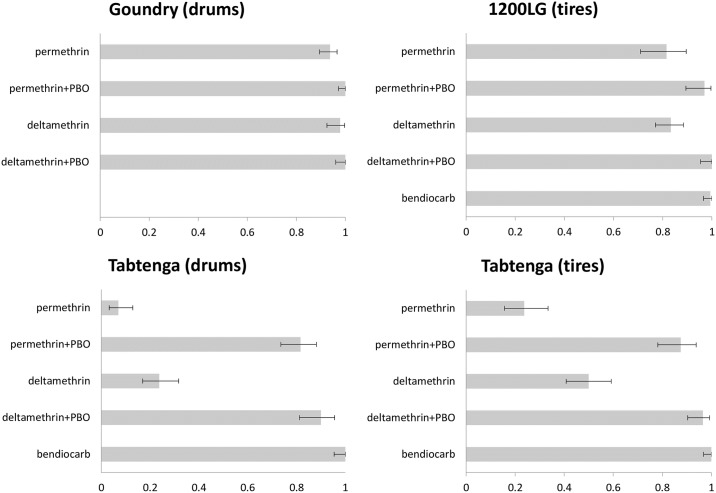
CDC 2h bottle bioassay mortality (x-axis) from each site, with breeding site type indicated.Error bars show 95% binomial confidence intervals.